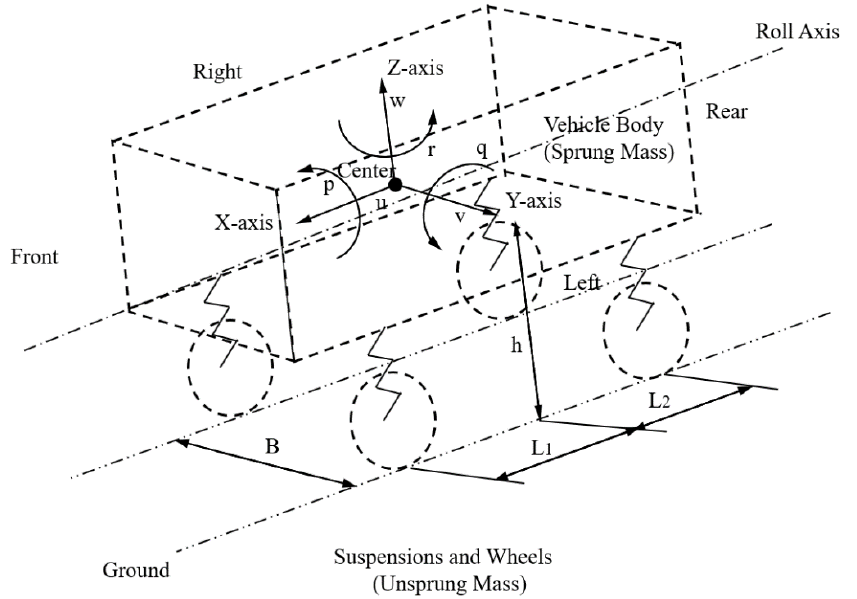
Figure 1. A 14-degree-of-freedom vehicle model (including longitudinal, lateral, vertical, roll, pitch and yaw direction of vehicle, and rotation and jump of each wheel).